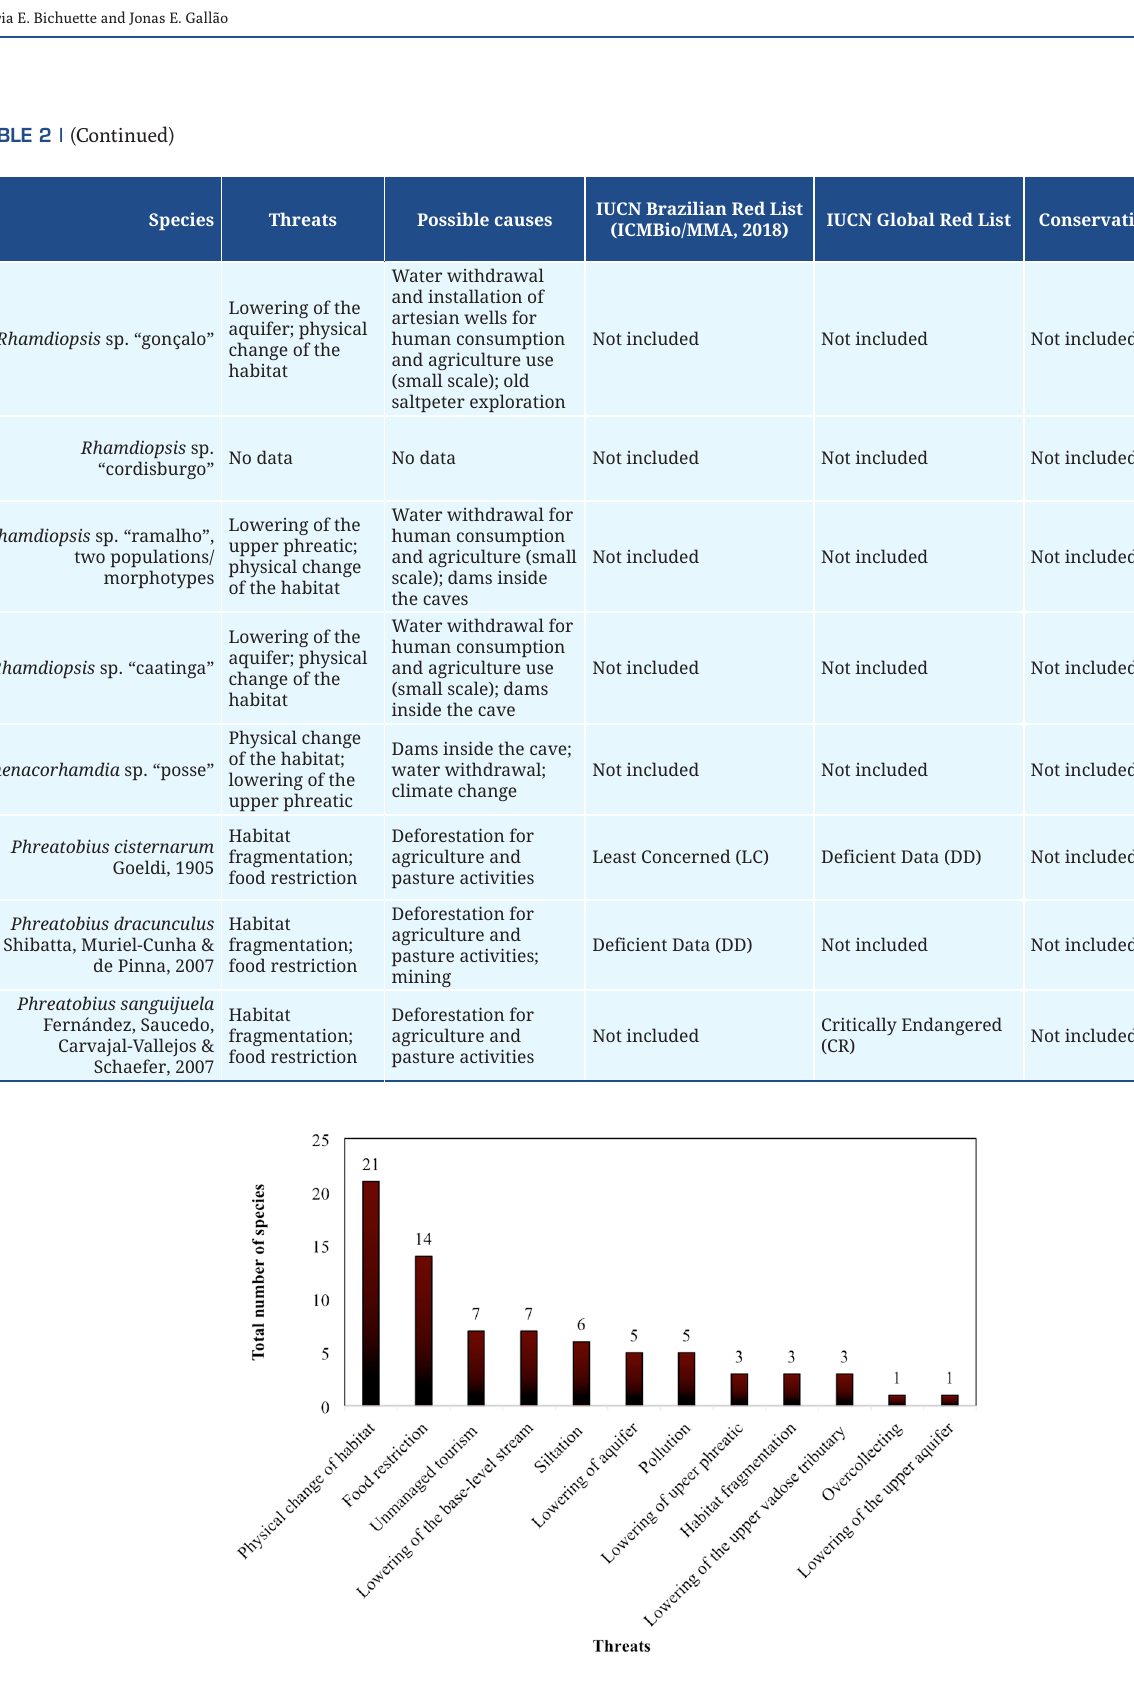
FIGURE 6 | Total number of Brazilian subterranean fish species affected by each type of identified threat in the present